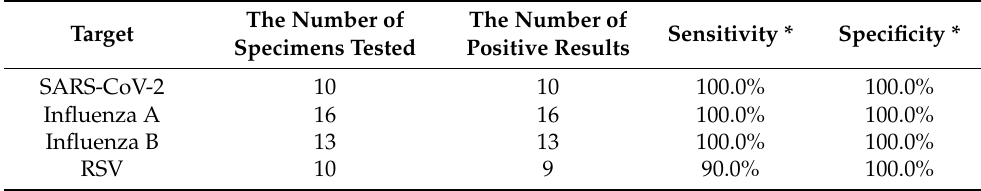
Table 2. The diagnostic sensitivity and specificity of CRISPR-Cas12a for detection of the